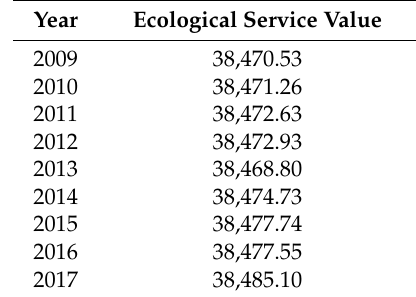
Table 2. Results of ecological service value of agricultural land from 2009 to 2017 in W County (yuan/hm 2 ).